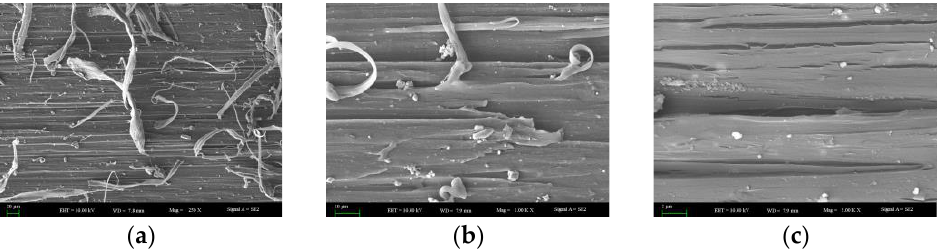
Figure 11. Microstructure of fracture surface of the PP specimens. ( a ) SEM image of 250 times; ( b ) SEM image of 1000 times; ( c ) SEM image of 5000 times.